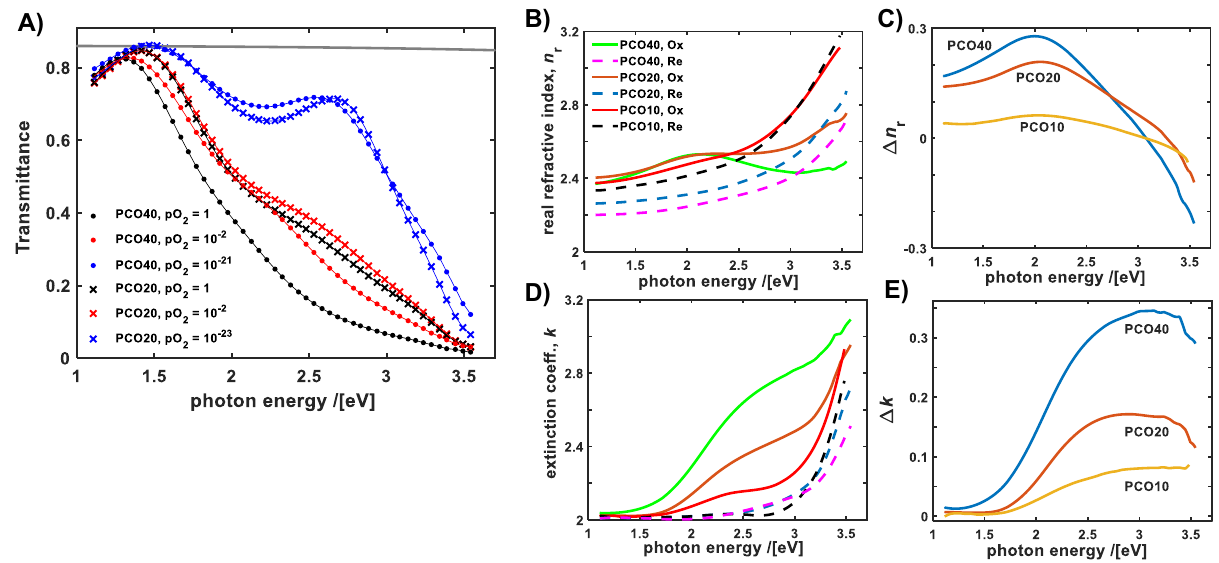
. Figure 2: Dependence of PCO optical properties on the equilibrium p O 2 (in bar units), as indicated in plot. (A) Optical transmittance of PCO20 (cross) and PCO40 (filled circle) at 500 ◦ C, equilibrated at various p O 2 O substrate transmittance, ∼ 0.87, is Symbols – experimental data points, curves–modeled transmittance (see text for details). Bare Al 2 3 of the PCO compositions in the most reduced (dashed curves) and most oxidized states (solid curves). shown as reference (grey curve). (B) n r , between the The PCO10 data was measured at 600 ◦ C (adapted from reference [25]). (C) Change in the real part of the refractive index, Δ n r as shown in (B) (the most oxidized and reduced states in (B). (D) k – the extinction coefficient of PCO compositions corresponding to the n r same legend applies to the both plots) (E) Change in the extinction coefficient, Δ k , between the most oxidized and reduced states in